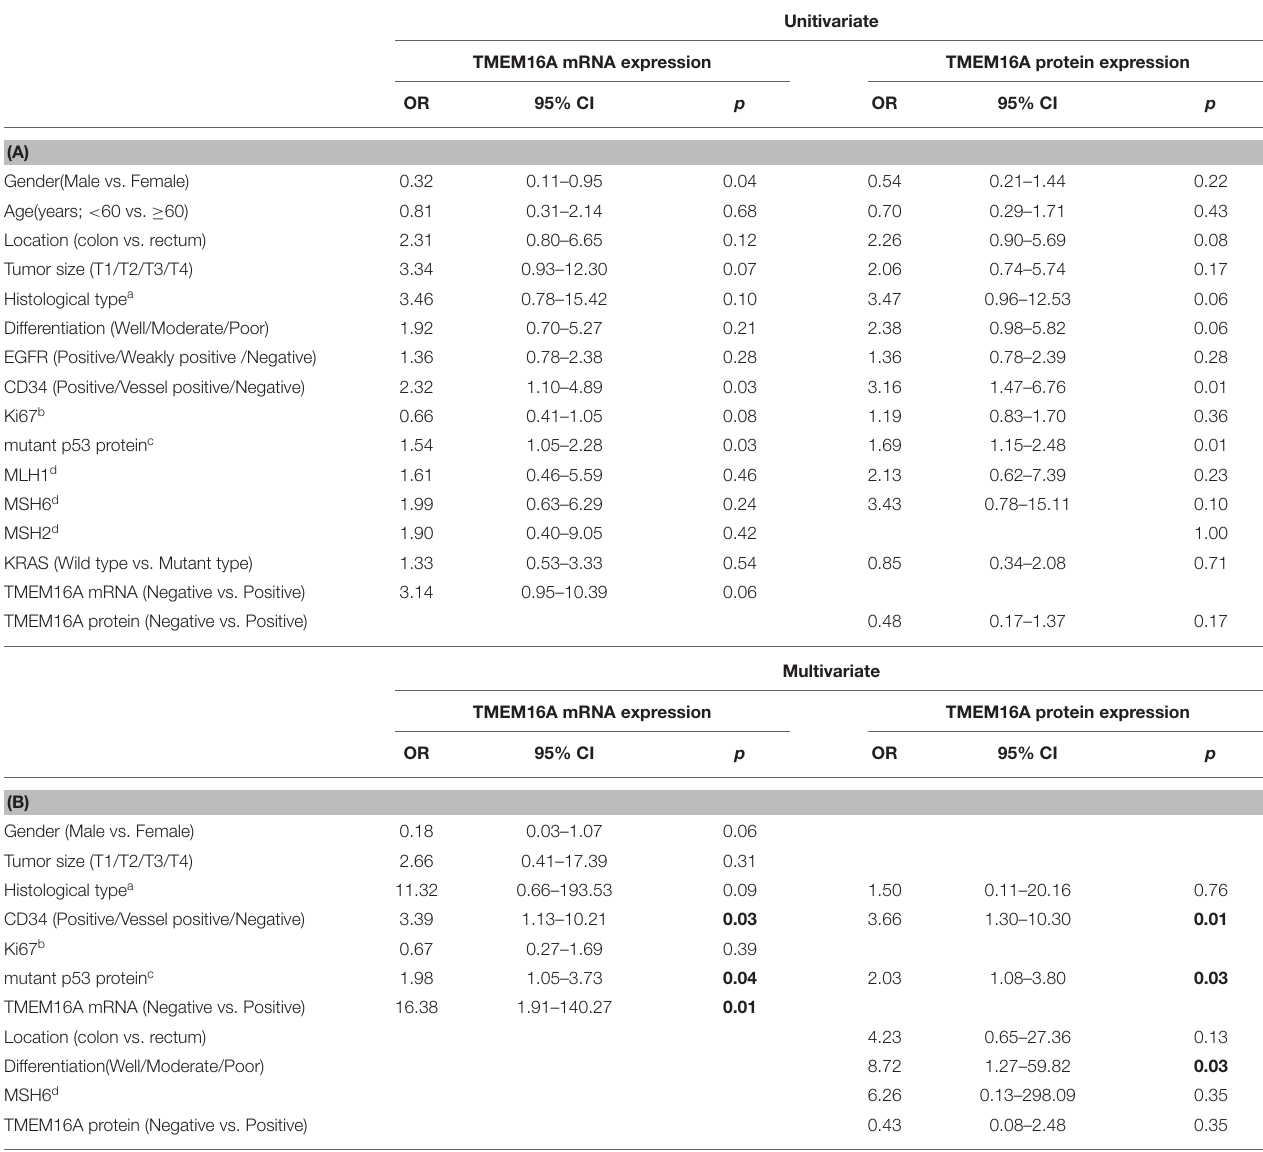
TABLE 6 | Univariate and multivariate logistic regression model for TMEM16A and